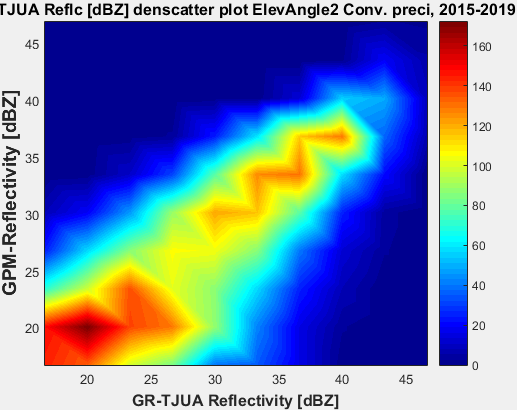
Figure 13. GPM ‐ Ka vs. NEXRAD TJUA for convective precipitation (angle 2).